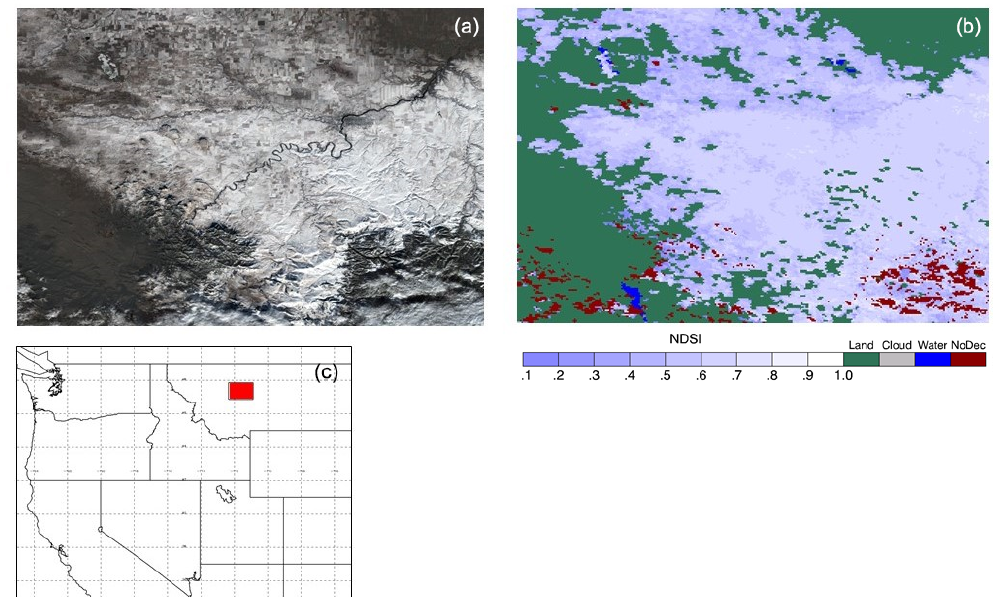
Figure 7. (a) Sentinel-2A “true-color” image showing snow cover in shades of white and gray, acquired on 2 December 2016 for a region of interest (ROI) in the state of Montana, USA. Black indicates non-snow-covered ground. (b) The MOD10A1F cloud-gap-filled (CGF) snow map of the same area and on the same date as is shown in (a) . In the CGF snow map in (b) , snow is depicted in various shades of white and purple, corresponding to normalized-difference snow index (NDSI) values. Pixels shown in red represent “no decision” by the NDSI algorithm. (c) The red box corresponds to the location of the images in the ROI in Montana, shown in (a) and (b) . The location map in (c) was obtained from Interactive Data Language (IDL) software that uses Natural Earth raster + vector map data, which are in the public